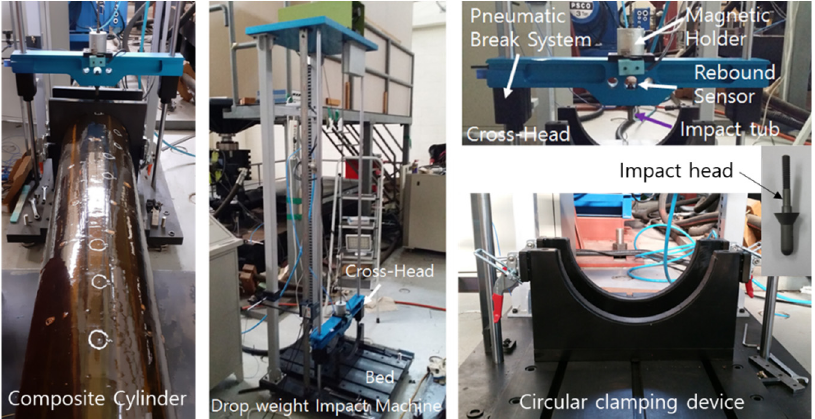
Figure 3. Photo of the drop weight impact machine equipped with an optical-fiber-embedded composite cylinder.